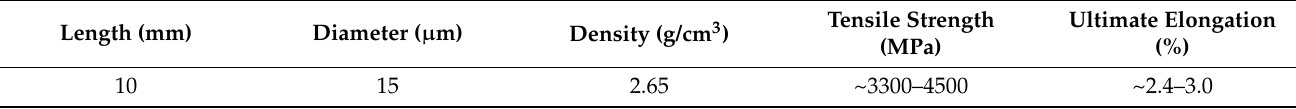
Table 3. Physical properties of basalt